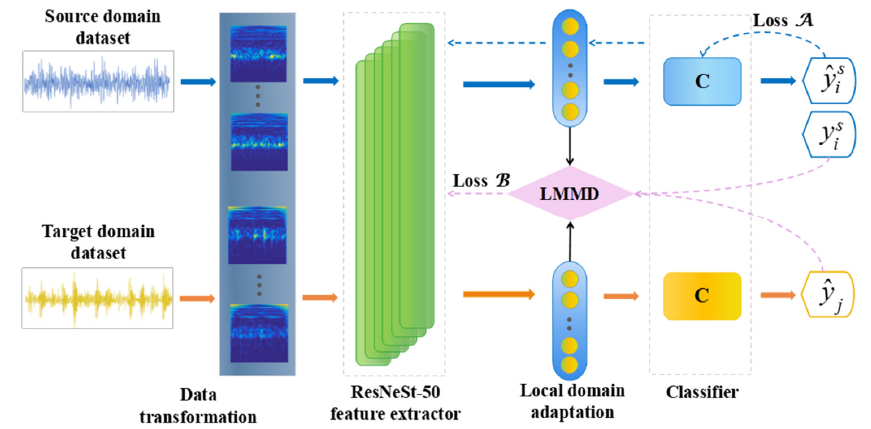
Figure 4. The structure diagram of the SPDSAN network model.